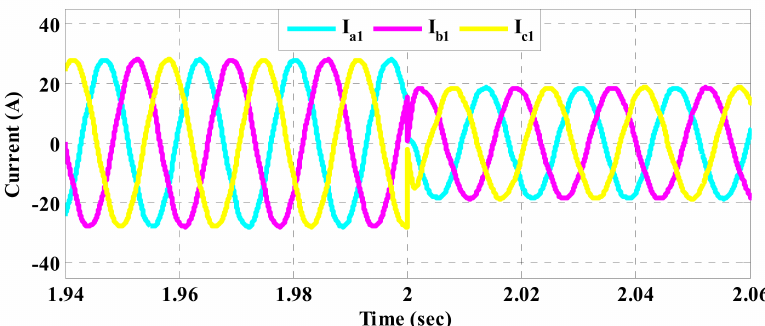
Figure 10. Injected current waveforms of DG1 based on the conventional control method.